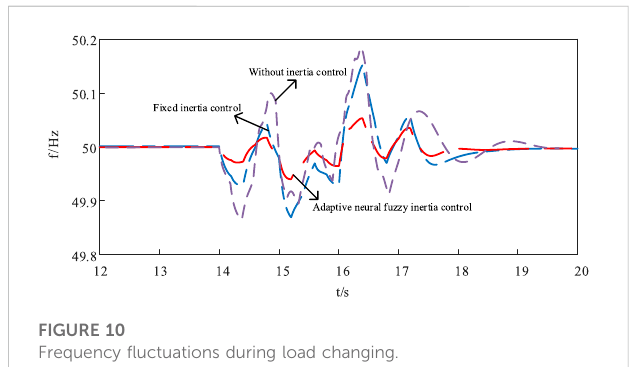
FIGURE 13 Power fl uctuations during load